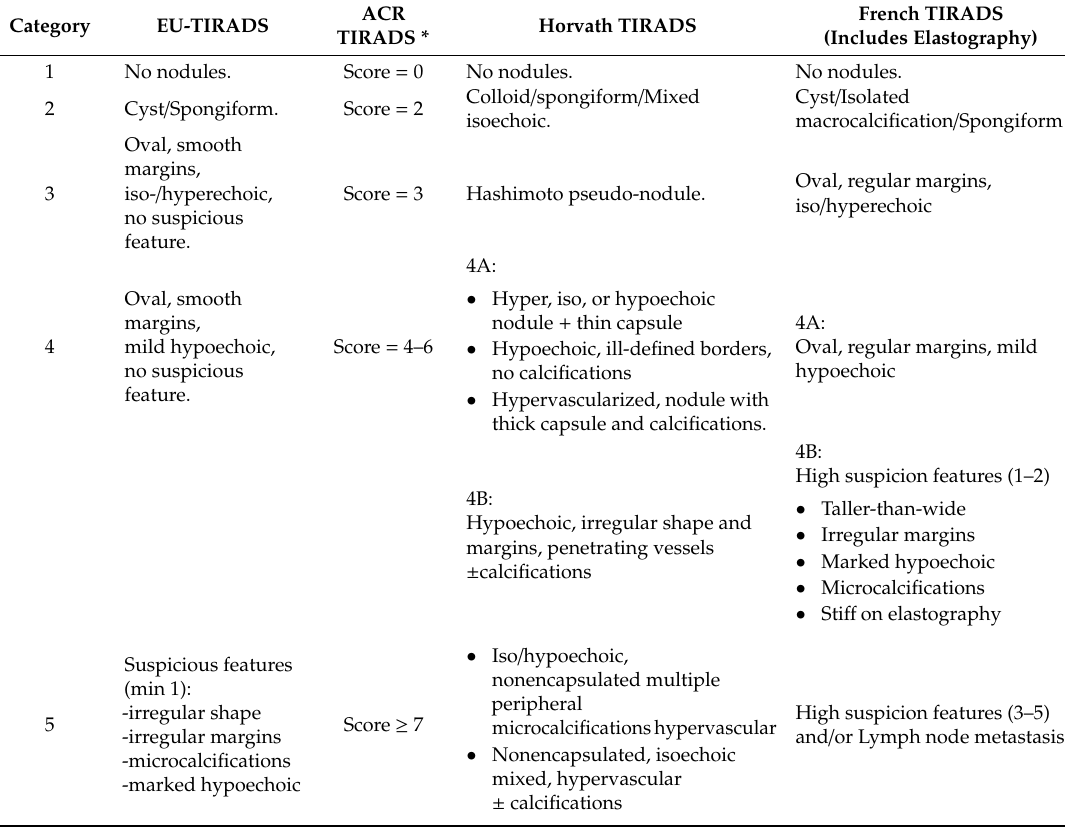
Table 1. Comparative US Classification of Nodules used in the study: European Thyroid Imaging and Reporting Data System (TI-RADS) versus American College of Radiology (ACR) TI-RADS (2016) versus Horvath TI-RADS (2009) versus French